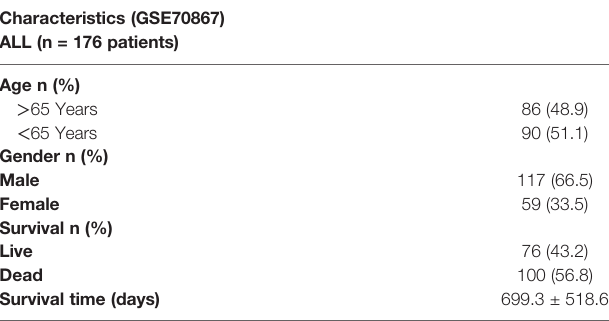
TABLE 1 | The clinical information of patients (GSE70867).